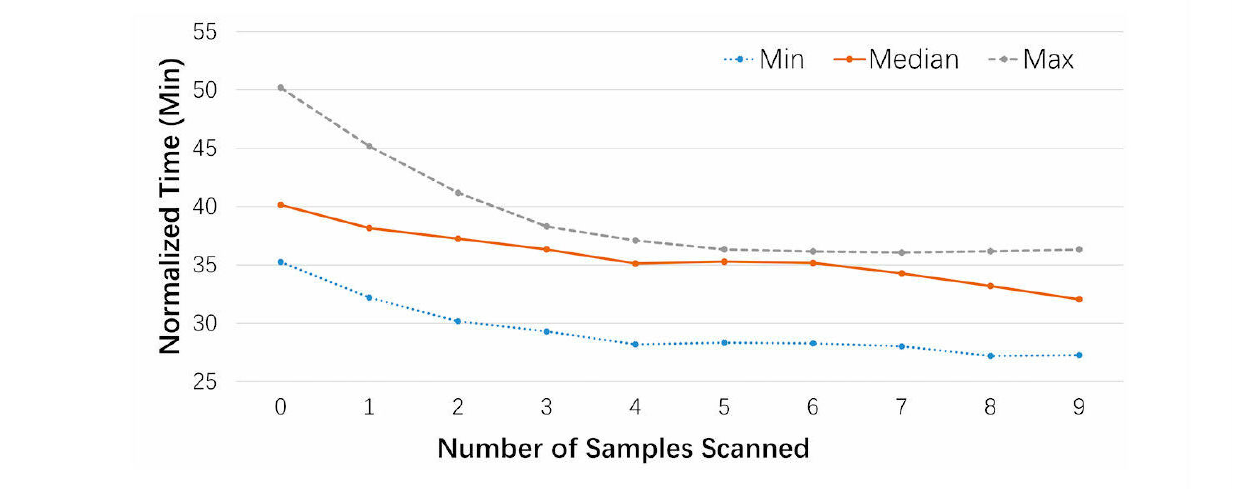
Figure 15. Normalized scan time versus number of samples